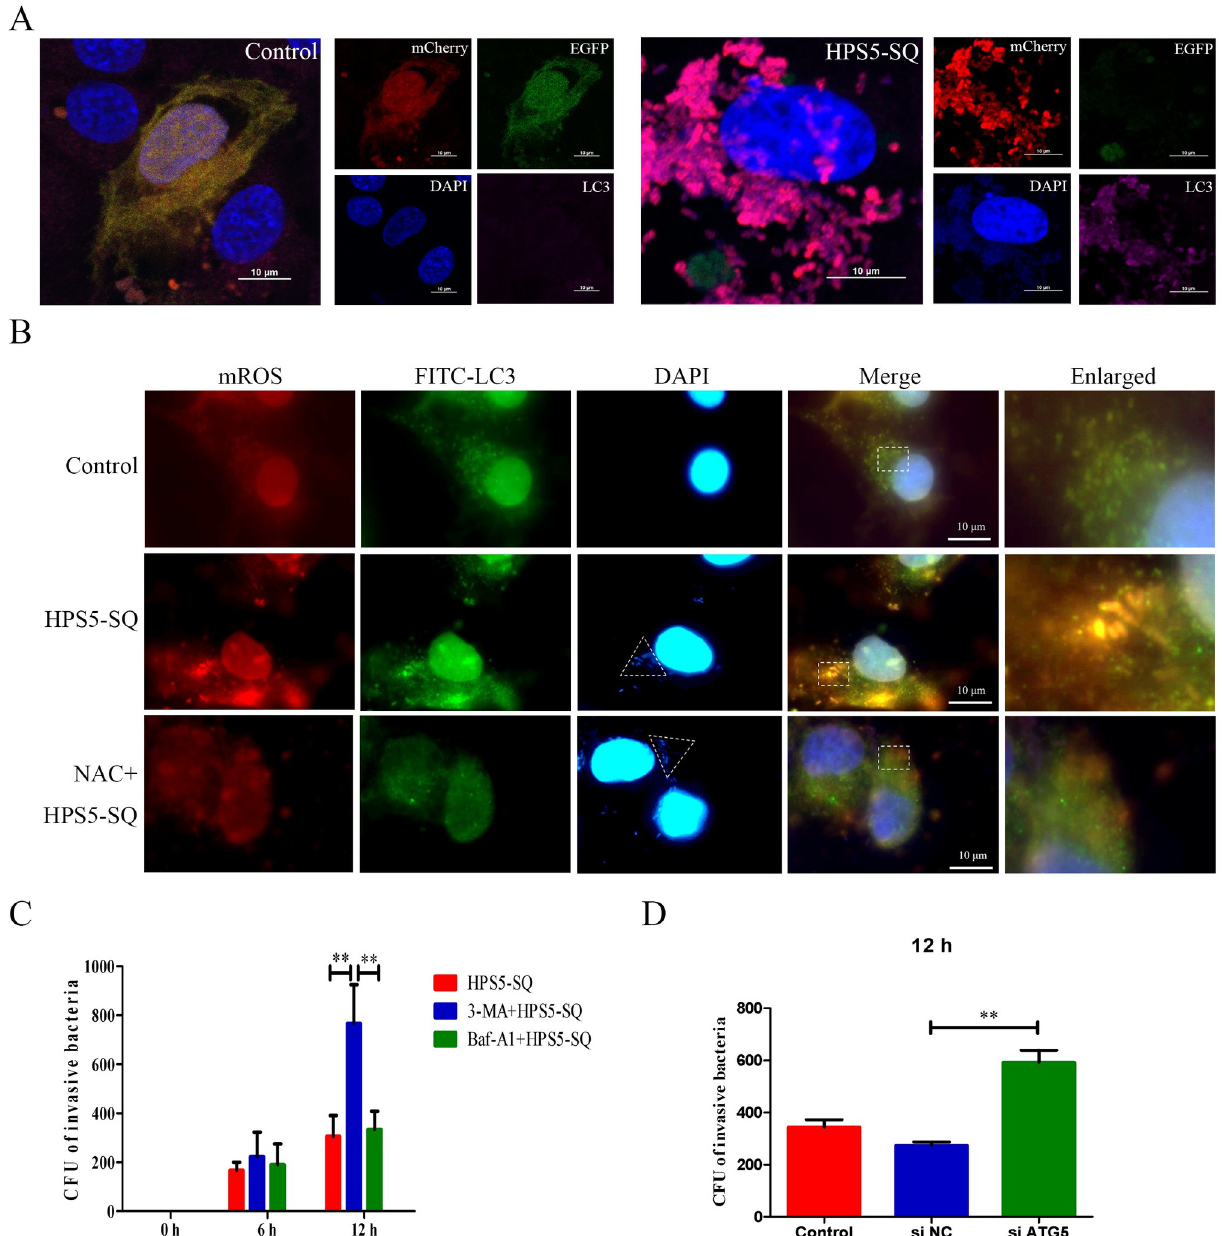
Fig 5. HPS5-SQ-mediated autophagy envelops mitochondria under oxidative stress and kills invading bacteria. (A) STEC were fixed and subjected to immunofluorescence analysis to detect LC3 (pink) and mitochondrial fluorescence (red and green). Scale bar: 10 μ m. (B) Immunofluorescence of control, HPS5-SQ, and HPS5-SQ+NAC (5 mM for the final 1 h) infected STEC stained for mROS and LC3B. The white triangle refers to HPS5-SQ (blue). Scale bar: 10 μ m. (C) STEC were treated with 3-MA for the final 3 h or Baf-A1 for the final 4 h, quantifying the invading HPS5-SQ in the infection of HPS5-SQ for 6 and 12 h. Data shown are means ± SEM; �� P < 0.01. (two-way ANOVA). (D) STEC were treated with ATG5 siRNA for 24 h and infected with HPS5-SQ for 12 h. Quantification of the invading HPS5-SQ. Data shown are means ± SEM; �� P < 0.01. (one-way